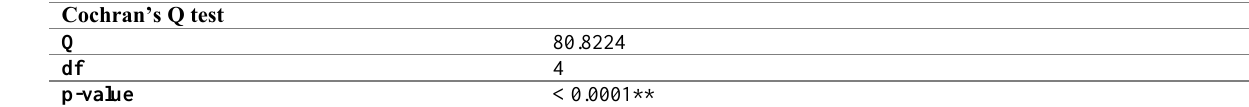
Table 2: Cochran’s Q Test for